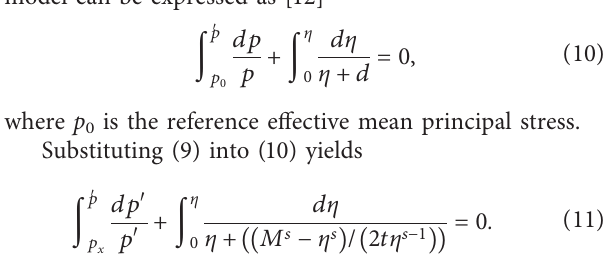
Figure 7: Effect of material parameters s and t on the high-order dilatancy equation. (a): s -high-order dilatancy equation ( D σ 3 � 50kPa, M � 1.37, and t � 0.75). (b) t -high-order dilatancy equation ( D r � 0.55, σ 3 � 50kPa, M � 1.4, and s �